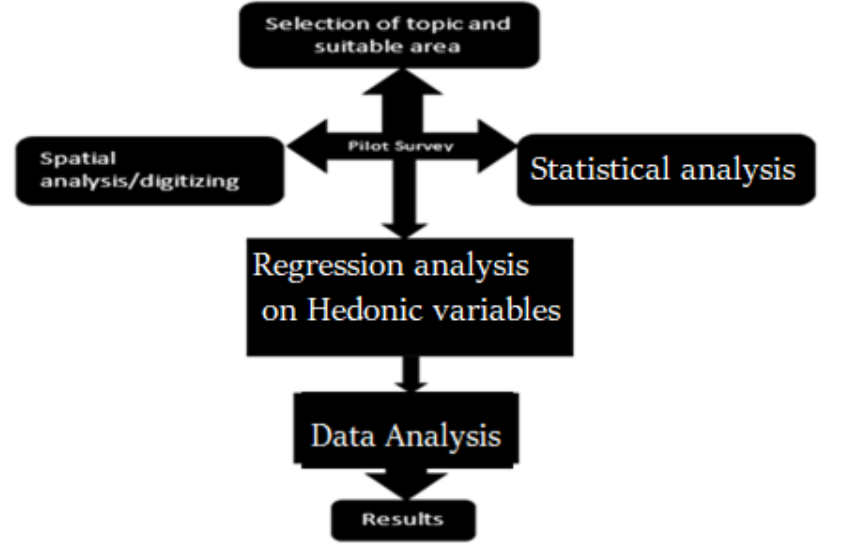
Figure 1. Framework of methodology.